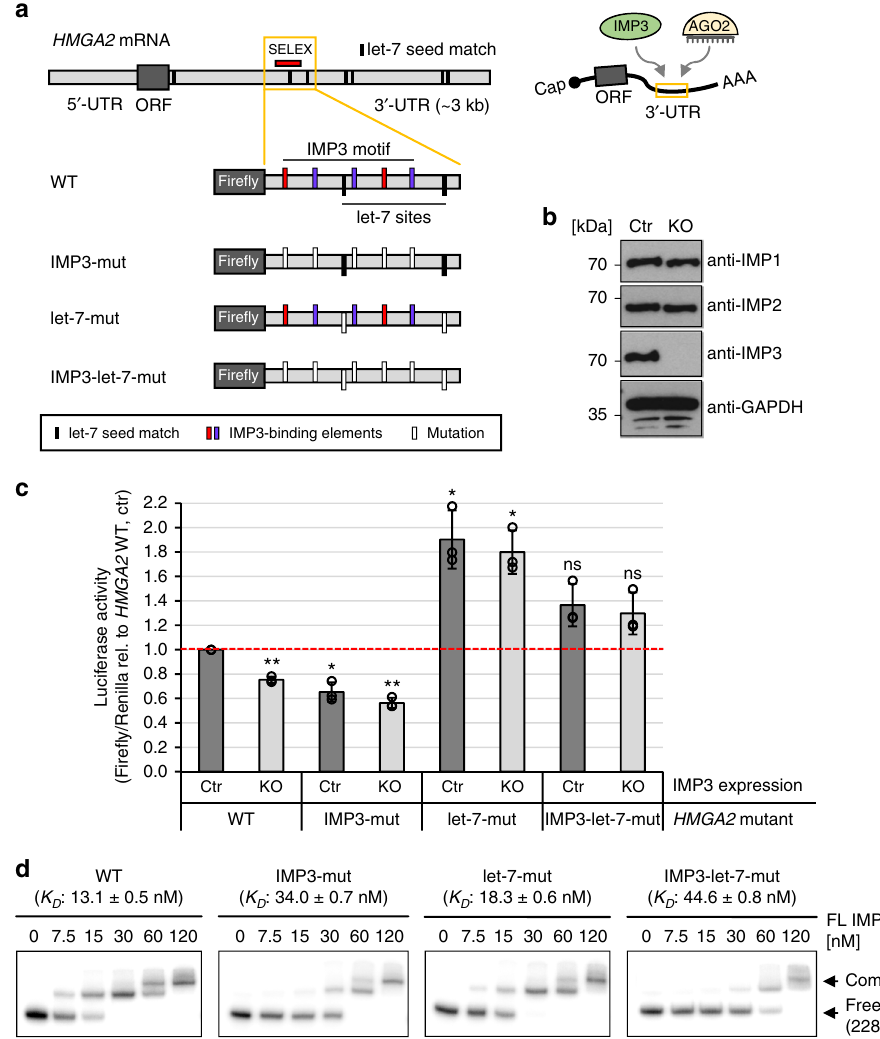
Fig. 8 Cross-regulation of HMGA2 mRNA expression by let-7 miRNA and IMP3. a Schematic of the HMGA2 mRNA, indicating the seven let-7 miRNA seed matches (black bars) in the 3 ′ -UTR and the SELEX-consensus array (red bar). Below, the structures of luciferase wild-type (WT) and mutant reporters are given, containing the HMGA2 3 ′ -UTR region (yellow box) with the IMP3 SELEX-consensus array and two let-7 seed matches. To measure the effect of IMP3 binding, IMP3-binding elements were mutated (IMP3-mut, GGC/CA ->UG, red/violet bars); for analysis of the let-7 in fl uence, the two seed matches in this region were inactivated (let-7-mut, UACCUCA ->UAaCgCA, black bars). In addition, both mutations were combined (IMP3-let-7-mut). On the right, binding of IMP3 and the let-7-AGO complex within the HMGA2 3 ′ -UTR is schematically represented. b Western blot analysis of standard (ctr) and CRISPR/Cas9 genome-engineered IMP3-knockout (KO) ES-2 cells, detecting endogenous levels of IMP1, IMP2, and IMP3. GAPDH was used as loading control. c Standard (ctr) and IMP3-knockout (KO) ES-2 cells were transfected with luciferase constructs described in a . Luciferase activities were measured as a ratio of Fire fl y/Renilla activity and compared with control cells transfected with the HMGA2 WT construct (statistical deviations based on biological triplicates; p < 0.005 ** , p < 0.001 *** , ns = not signi fi cant, two-sided t test). d EMSA assays with 32 P-labeled HMGA2 mutant RNAs (0 – 120 nM IMP3 and 5 nM RNA; mean and standard error of three experiments, Hill coef fi cients of n = 3.1 ± 0.3 for WT, n = 6.0 ± 0.8 for IMP3-mut, n = 4.7 ± 0.6 for let-7-mut, and n = 3.5 ± 0.2 for IMP3-let-7-mut), containing the SELEX motif and a single let-7 seed sequence (see red bar in a ). Source data are provided as a Source Data fi